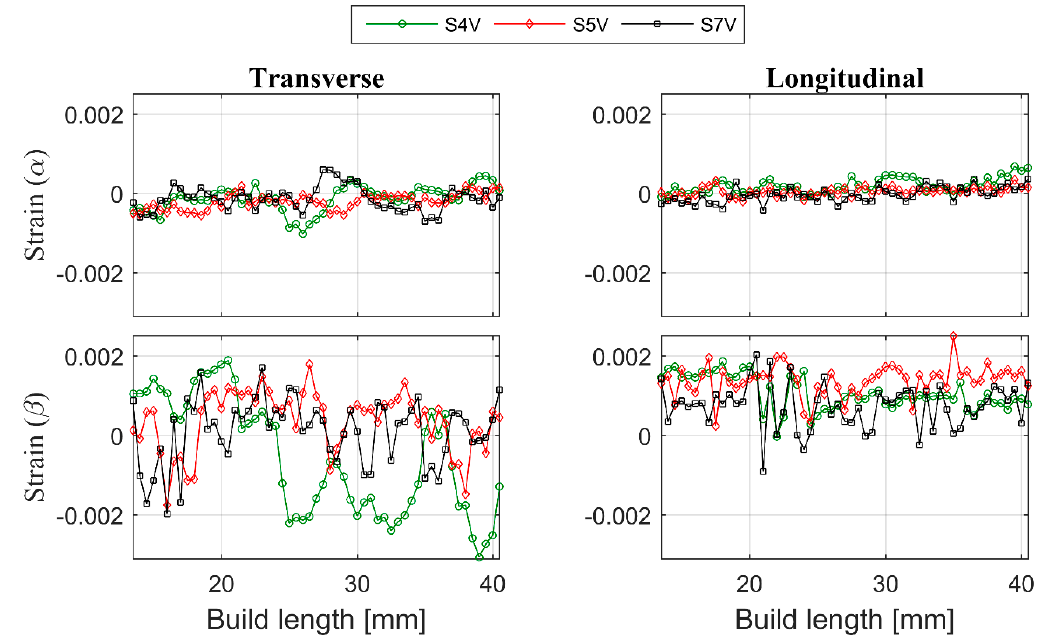
Figure 10. The lattice strain from the central vertical line of specimens perpendicular to the EBM build plane. Transverse direction at left and longitudinal direction at right. Color code of each specimen can be seen from the legend at top of the figure.